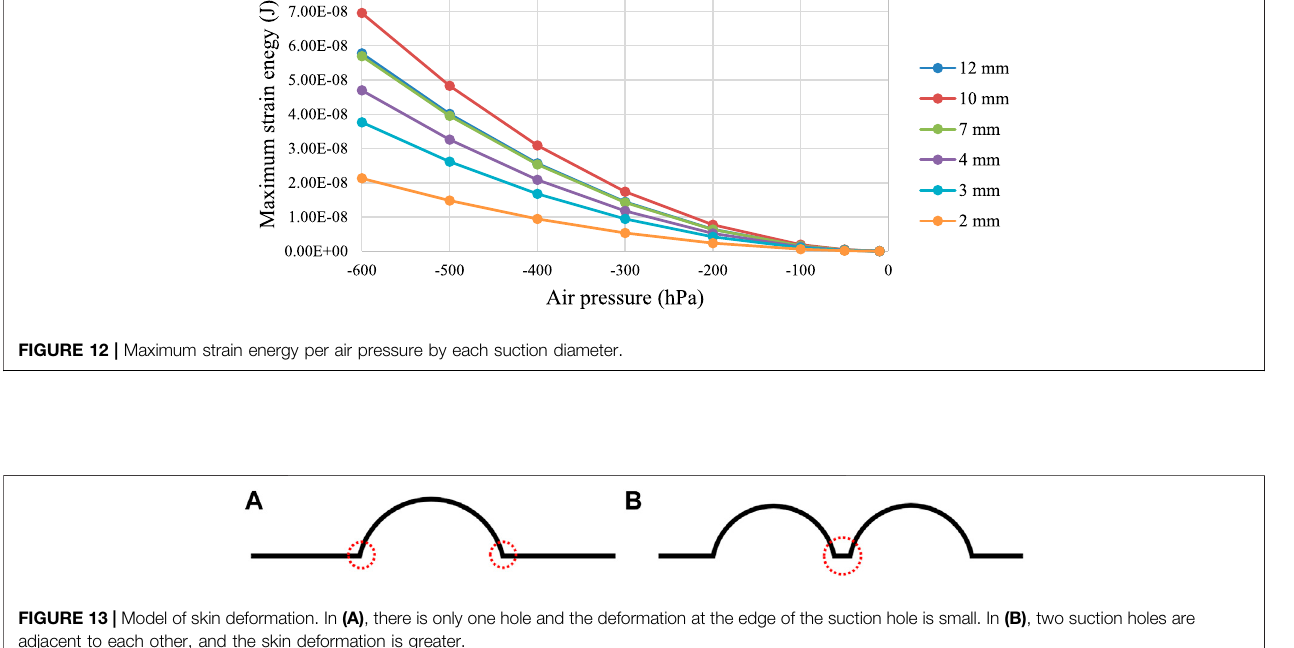
Frontiers in Virtual Reality |